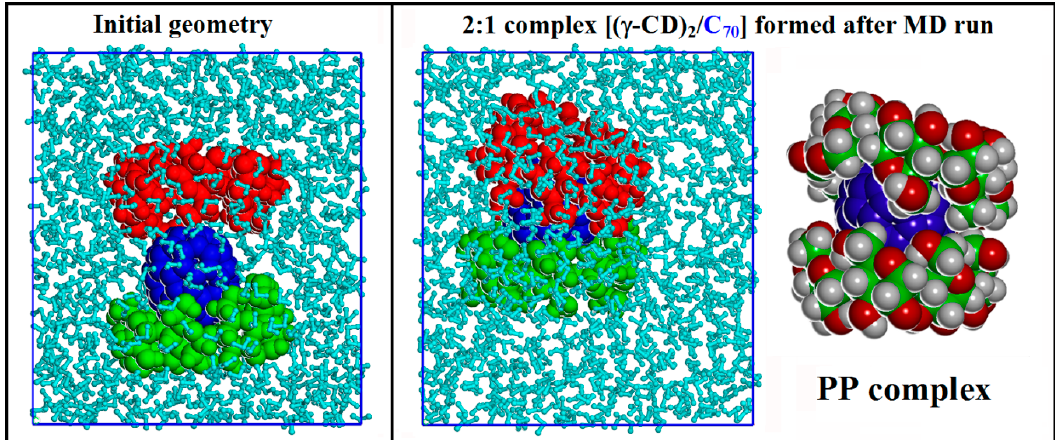
Figure 5. The complex γ -CD with C 70 in a stoichiometry 1:1 in water facing the primary rim of the second γ -CD (at left), to study the formation of the complex in a 2:1 stoichiometry after 2 ns of MD run in explicit solvent (at right). The most stable geometry obtaind for the complex where the CD face their primary rims (PP complex) is also shown after removing the water molecules for clarity.